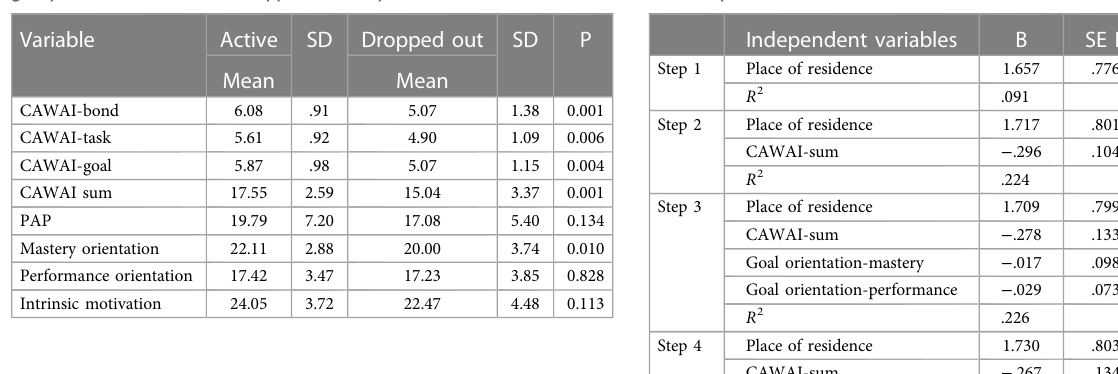
TABLE 2 Independent samples t -test with mean, standard deviation and p -values for the group of athletes who are still active ( n =19) and the group of athletes who had dropped out of sport ( n =97).